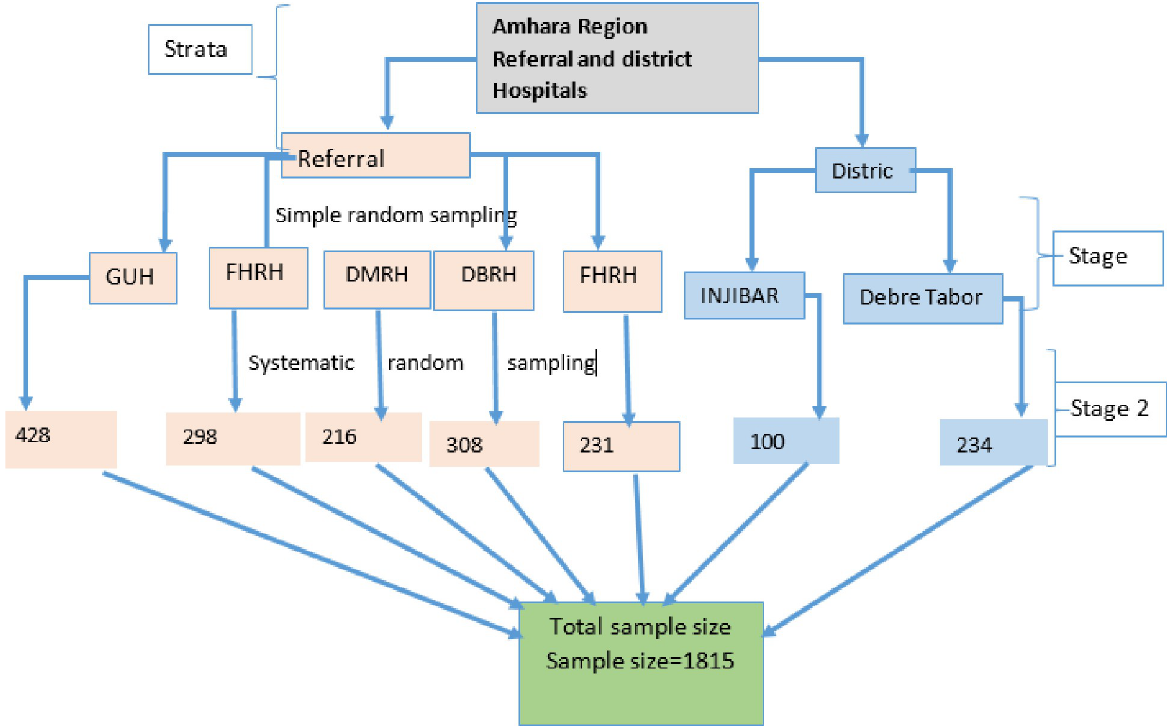
Fig 1. Schematic presentation of sampling procedures (note that; RH and referral hospital, DH: District hospital).